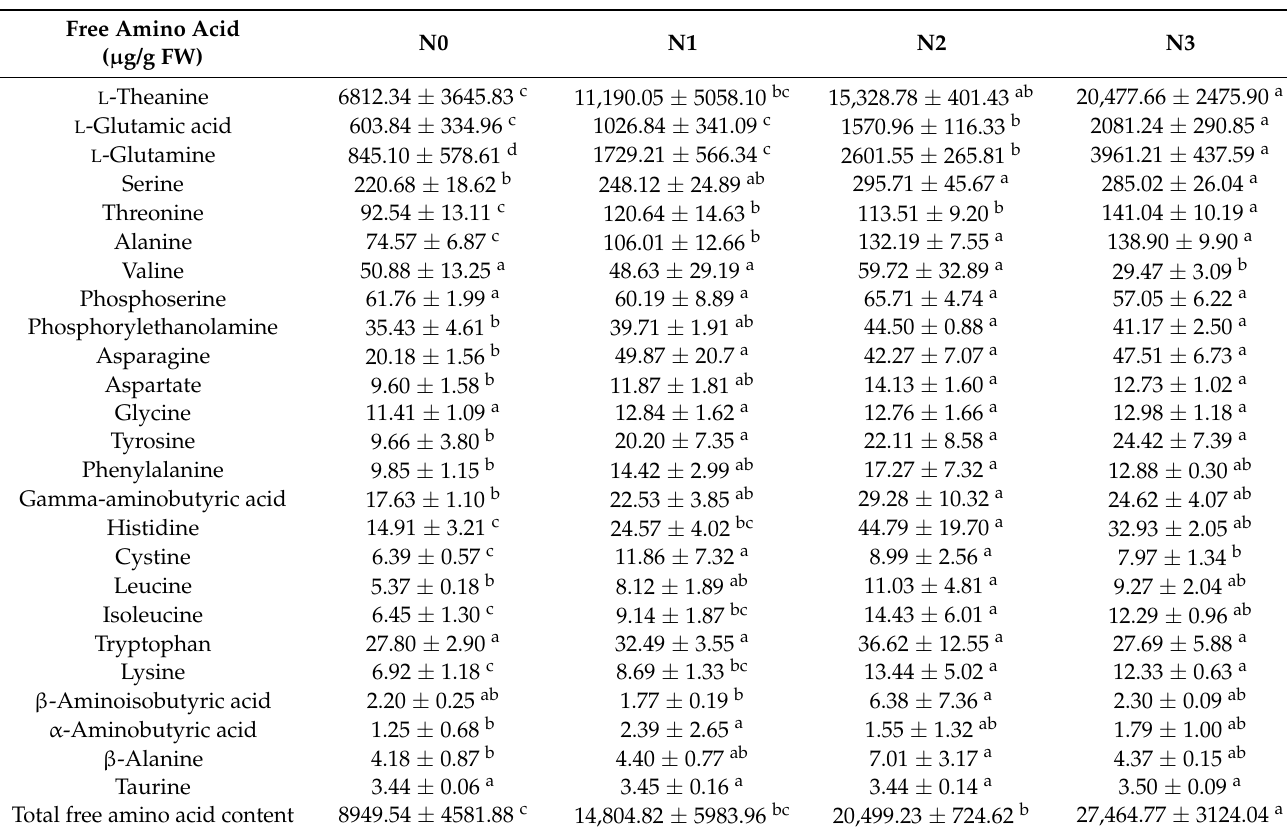
Table 3. Effects of long-term nitrogen application on the contents of free amino acid components in fresh tea leaves collected in